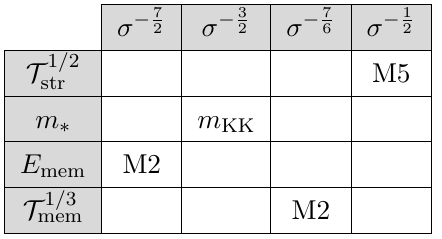
can be either fixed by the ∗